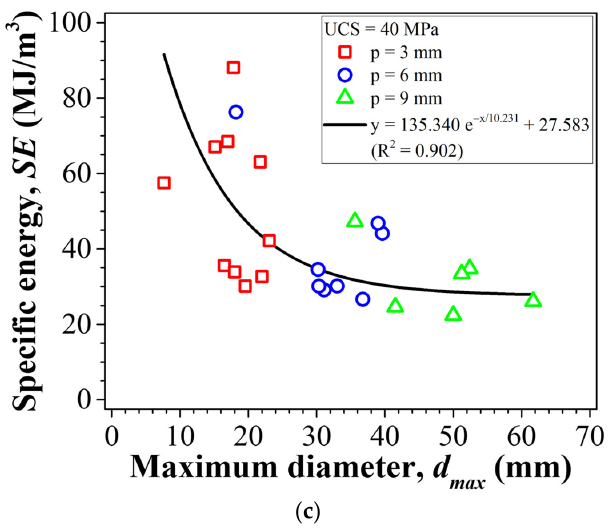
Figure 16. Relationship between maximum diameter and SE : ( a ) rock of UCS 20 MPa; ( b ) rock of UCS 30 MPa; ( c ) rock of UCS 40 MPa.